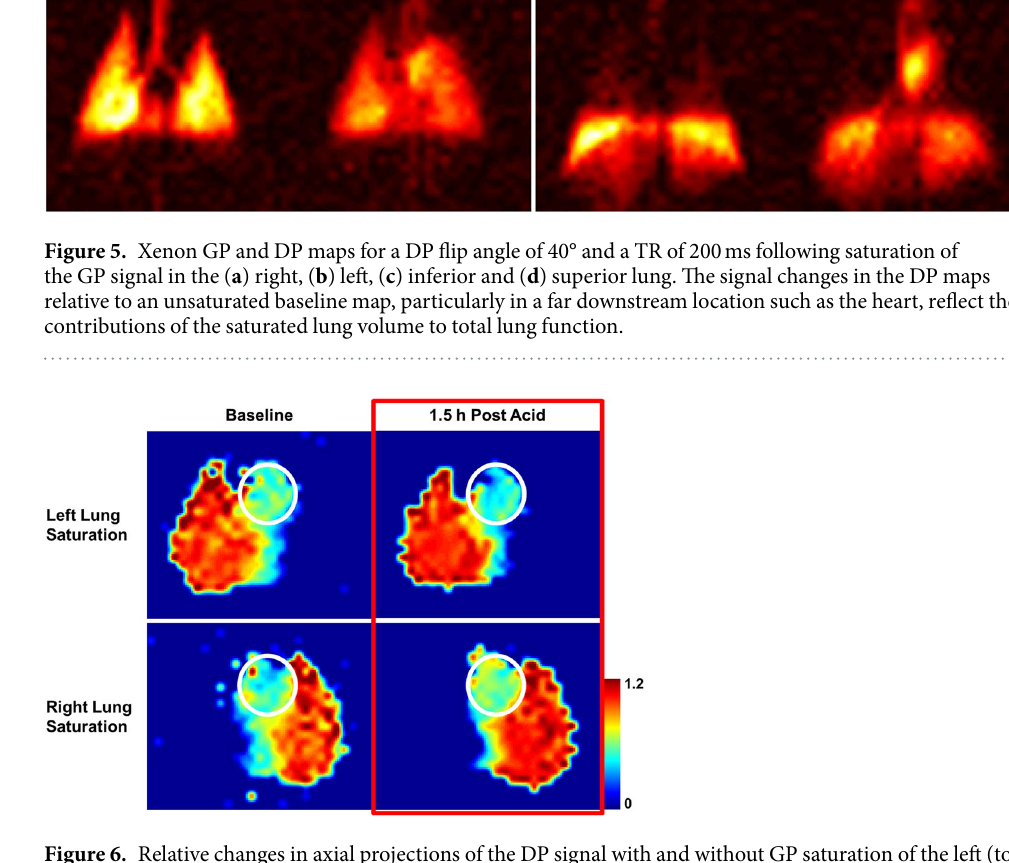
Figure 6. Relative changes in axial projections of the DP signal with and without GP saturation of the left (top row) or right (bottom row) lung at baseline and approximately 1.5 hours after administration of HCl to the right lung. The circles in each map highlight the far-downstream regions, including the